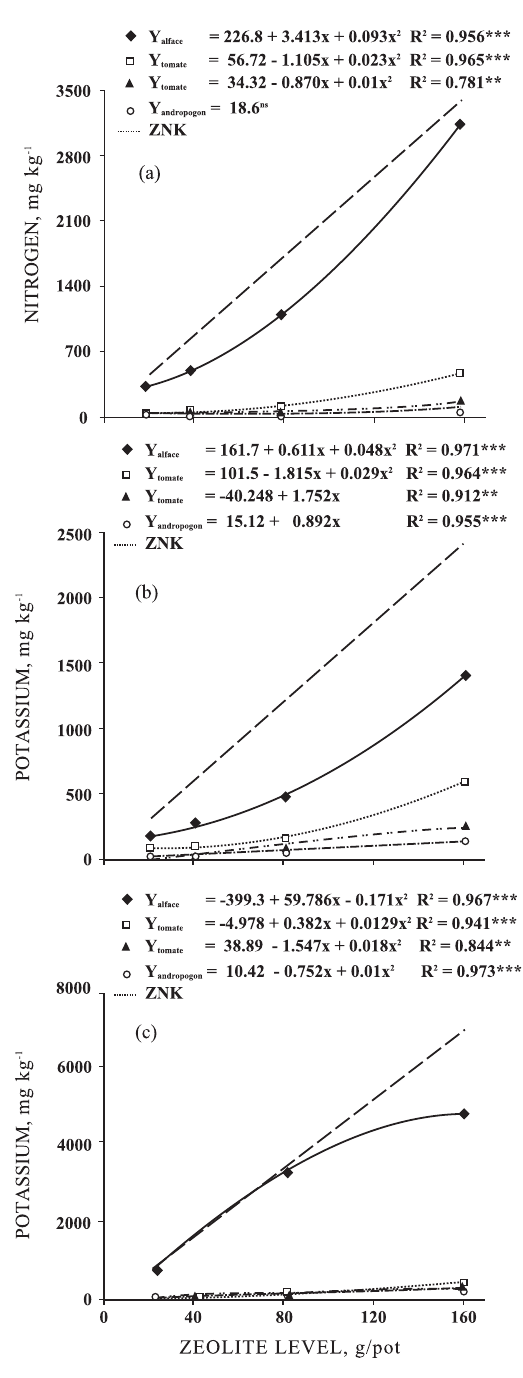
Figure 3. Nitrogen and K levels in the treatment zeolite + KNO (ZNK - a and b), K in the treatment 3 zeolite + K HPO (ZPK - c) in the saturation paste 2 4 extract of the substrate, after successive crops of lettuce, tomato, rice, and andropogon grass (two cuts). The dotted line indicates the level at the beginning of the experiment.